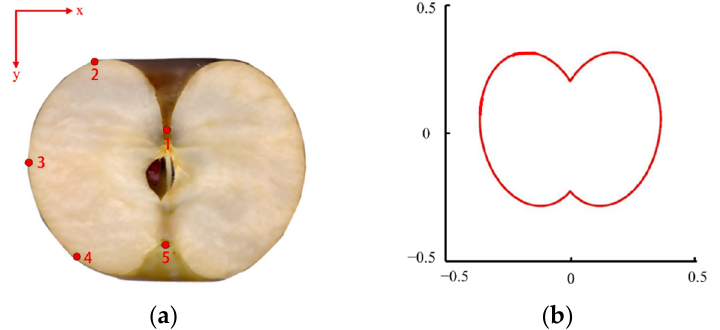
Figure 10. Apple conic fitting: ( a ) five representative points are selected on the front view of apple; ( b ) fit the apple conic of five points.